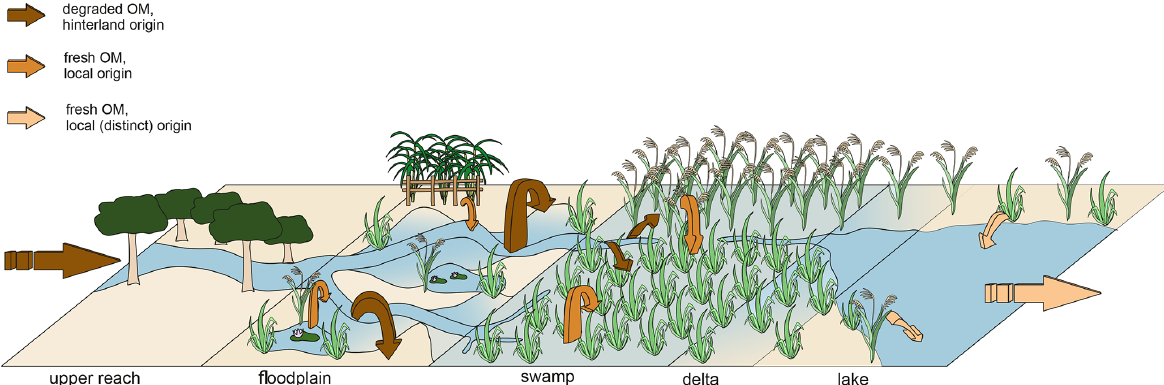
Figure 9. The figure shows a schematic summary of the characteristics and transport pathways of organic material in a terminal or flow- through wetland system under low-flow conditions. The vegetation types shown (trees, wetland sedges, grasses, and aquatic species) indicate the prominently occurring vegetation in each sub-environment of the Mkhuze Wetland System. Arrows indicate OM input and deposition, with thickness of arrows corresponding to OM quantity assumptions and colors corresponding to OM quality characteristics (dark brown: more degraded; light brown: less degraded, spatially different